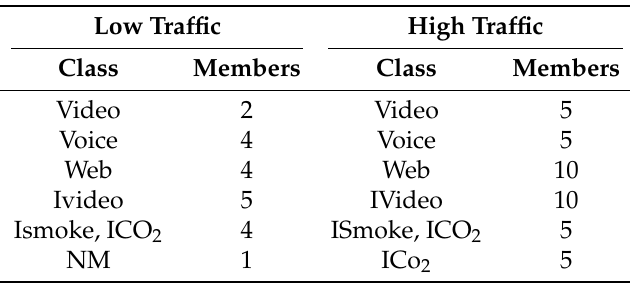
Table 4. QoS parameters for different